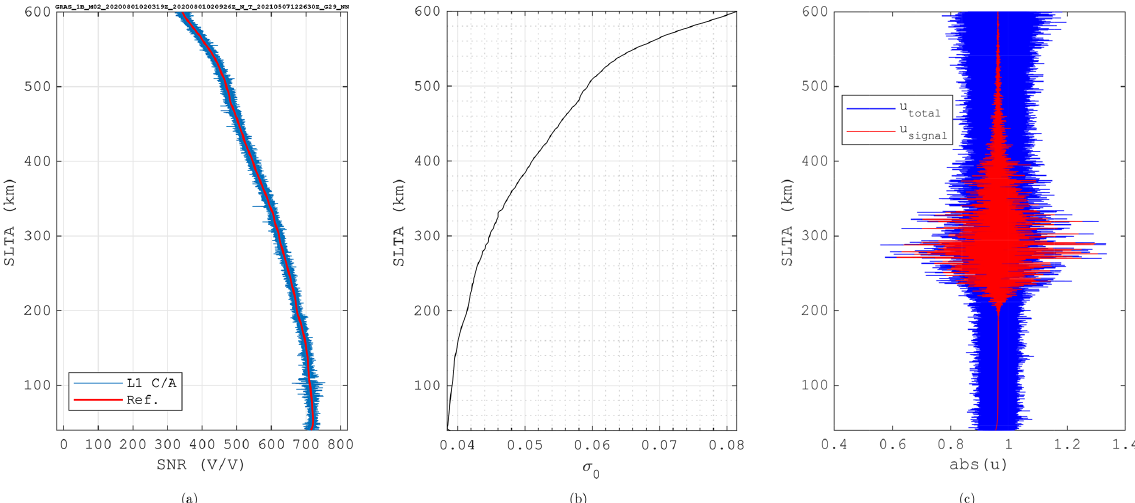
Figure A1. (a) L1 coarse acquisition (C/A) code SNR 1Hz : the blue curve shows the original SNR, and the red curve depicts the averaged curve, the values of which were used as a reference in Eq. (A18). The decay in SNR observed with increasing SLTA ( > 100km) is due to the antenna gain pattern. (b) The amplitude of the noise added to the WOP signal. (c) WOP amplitude with and without added noise on the observational plane (last PS; single-inbound-bubble scenario) (Carrano et al., 2011).